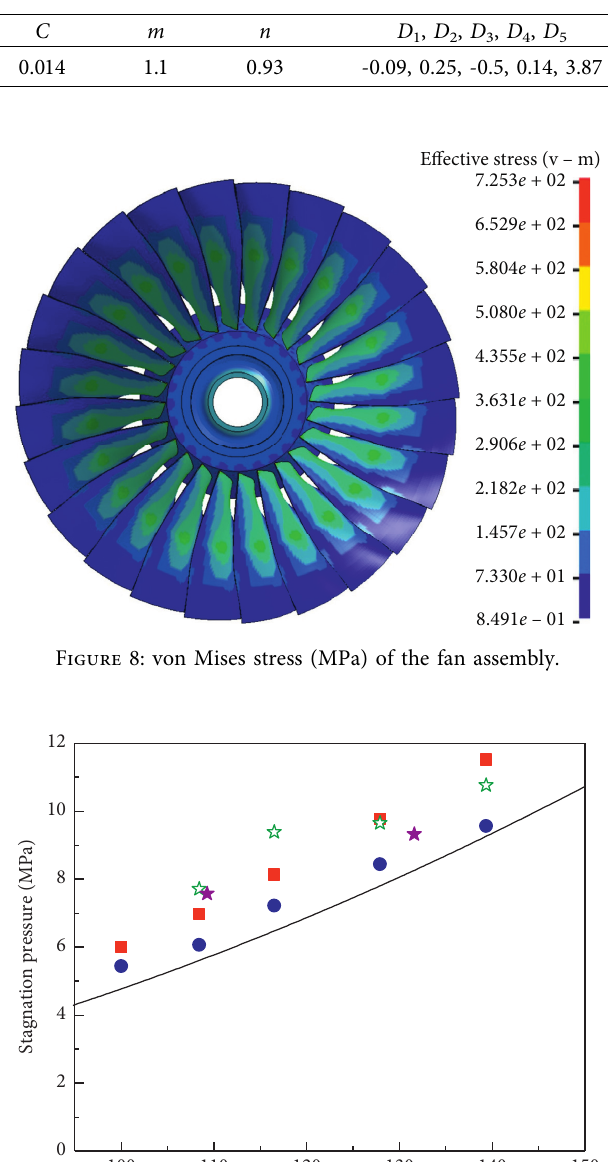
Table 1: Material properties of Ti-6Al-4V.